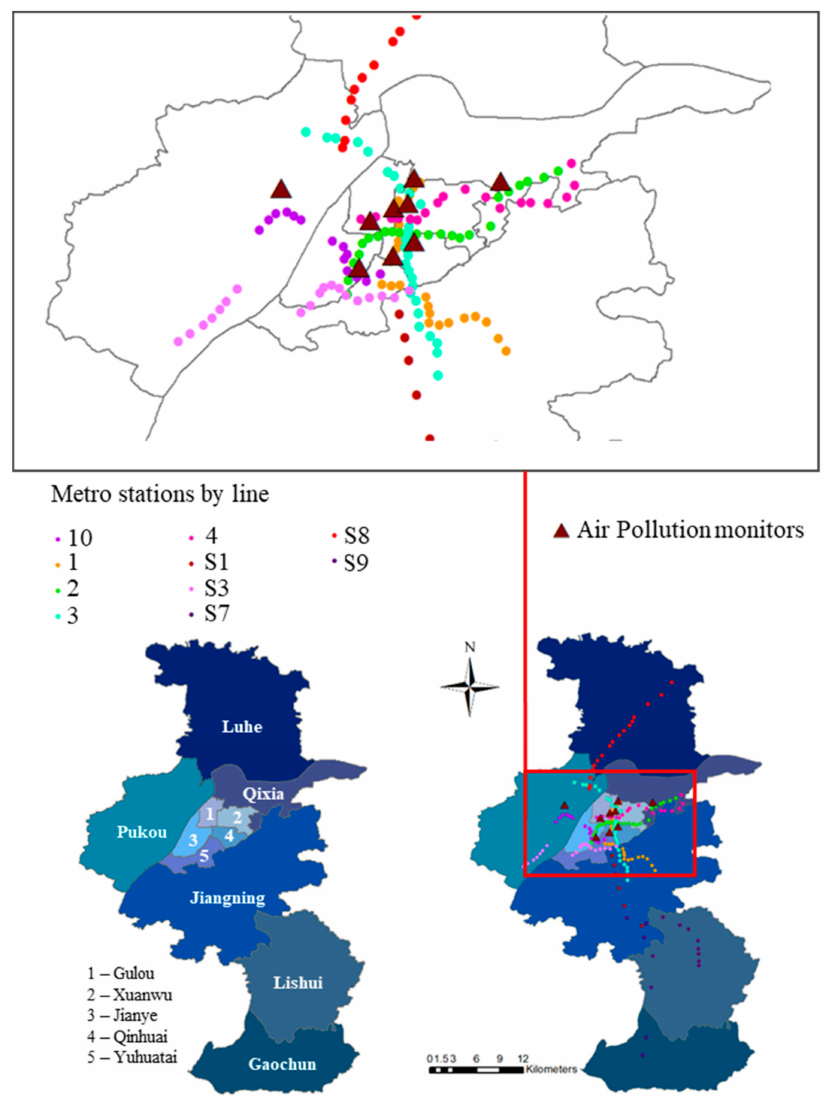
Figure 4. The spatial distribution of the nine air quality monitors and subway stations in